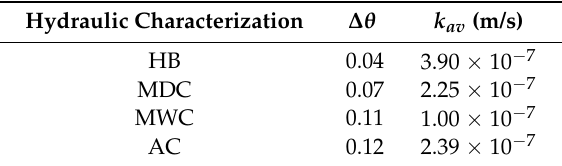
Table 2. Dominant factors ( k av = average hydraulic conductivity; ∆ θ = overall water content) in case A: HB (hysteretic behavior), MDC (main drying curve), MWC (main wetting curve), and AC (average